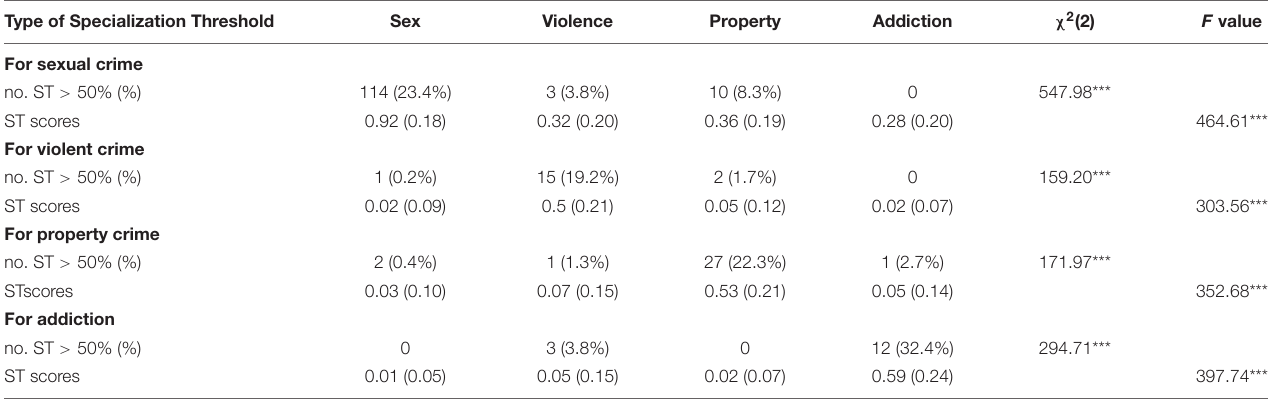
TABLE 3 | Between onset-groups comparison with sexual specialization.